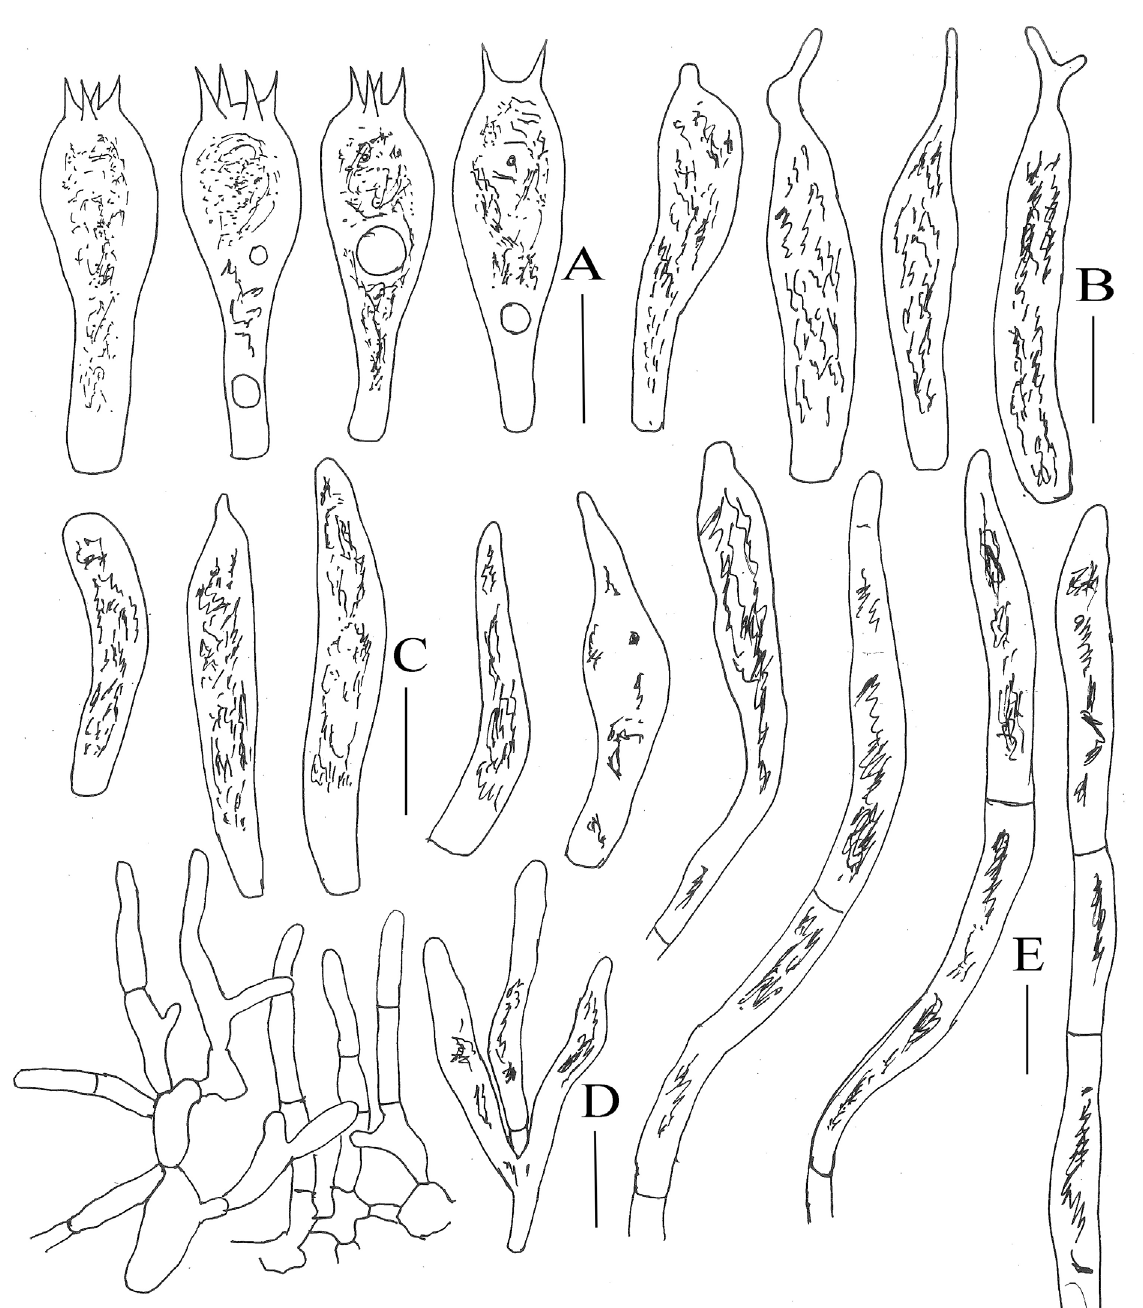
Fig. 4. Russula coronaspora Y.Song sp. nov. (GDGM79711, holotype). A . Basidia. B . Pleurocystidia. C . Cheilocystidia. D . Terminal elements in pileipellis. E . Pileocystidia. Scale bars = 10 μm. Drawing by Yu